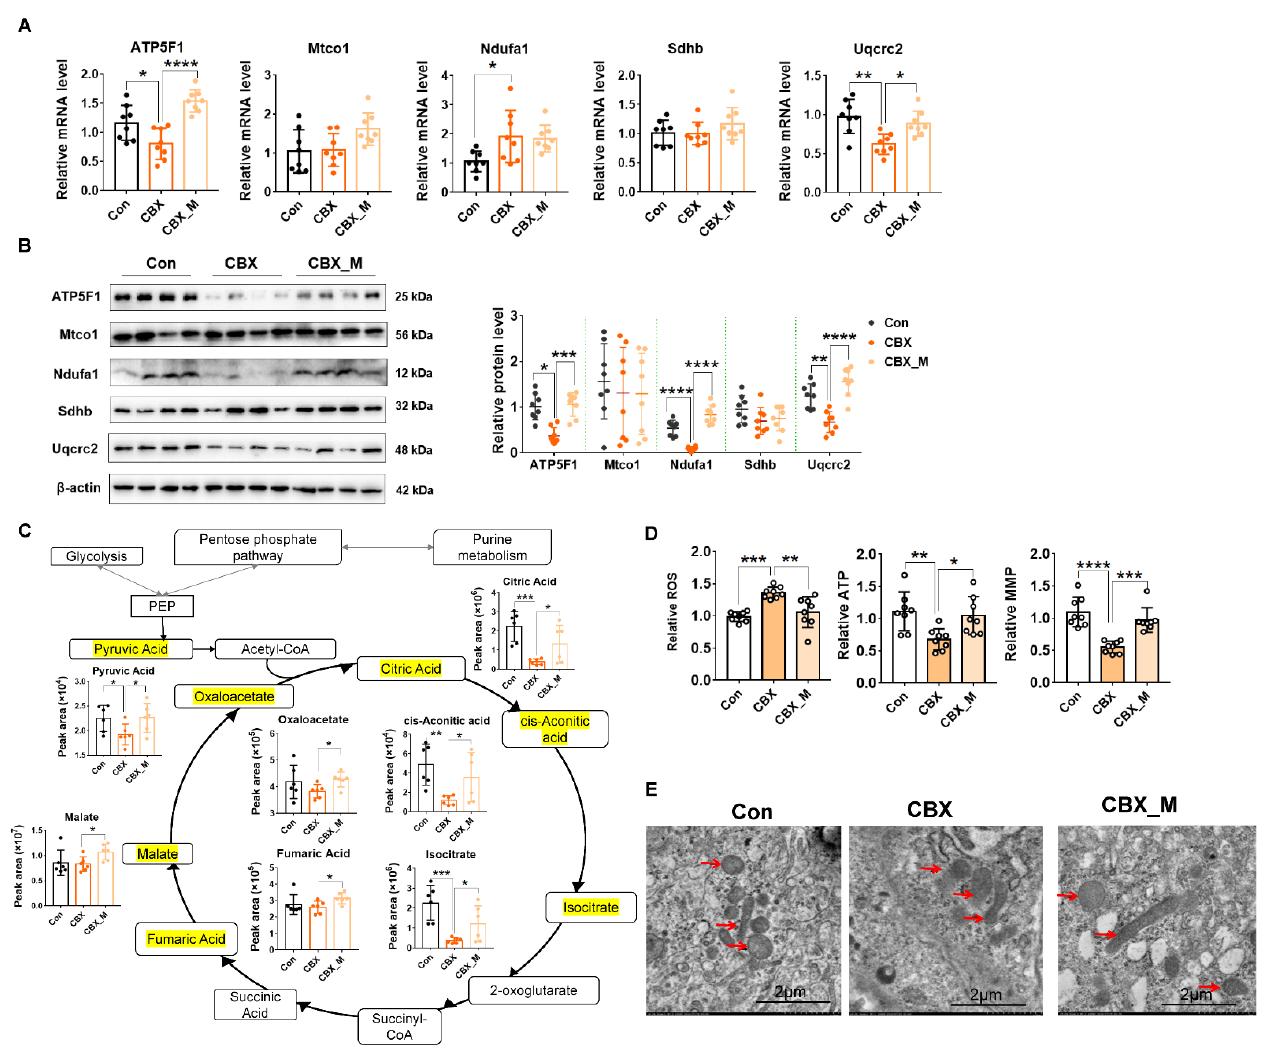
Figure 2. OXPHOS and mitochondrial functions are impaired in the placentas of PE-like model and mitoTEMPO treatment reverses them. Pregnant rats were administrated with CBX or saline from GD 7.5 to GD 17.5. The rats were sacrificed on GD 20.5, and the placentas were collected for analysis of mRNA and protein expression of various genes, targeted metabolomics and morphology. ( A ) the mRNA of the gene in OXPHOS electron transport chain components. ( B ) the protein levels of the gene in OXPHOS electron transport chain components. Left panel: representative images of Western blotting. Right panel: cumulative data of each protein expression level. ( C ) targeted metabolomics analysis of central carbon metabolism. Statistical chart shows peak area abundance of significantly altered metabolites in TCA cycle. ( D ) mitochondrial function assay of ROS, ATP and MMP. ( E ) electron microscope analysis of placental tissue. Representative images of electron microscope (10,000×). Red arrow: mitochondria. * p < 0.05, ** p < 0.01, *** p < 0.001, **** p < 0.0001. Con: control.